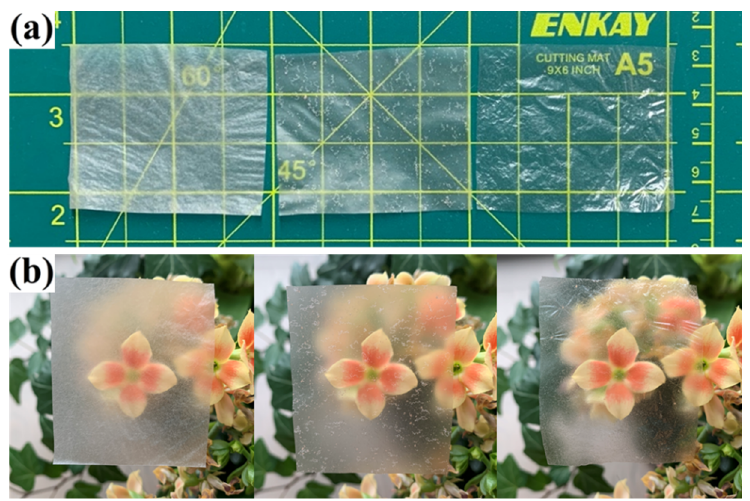
Figure 4. Digital pictures of regenerated cellulose films (HRC, NRC, and DRC from left to right) under ( a ) room light and ( b ) natural light.